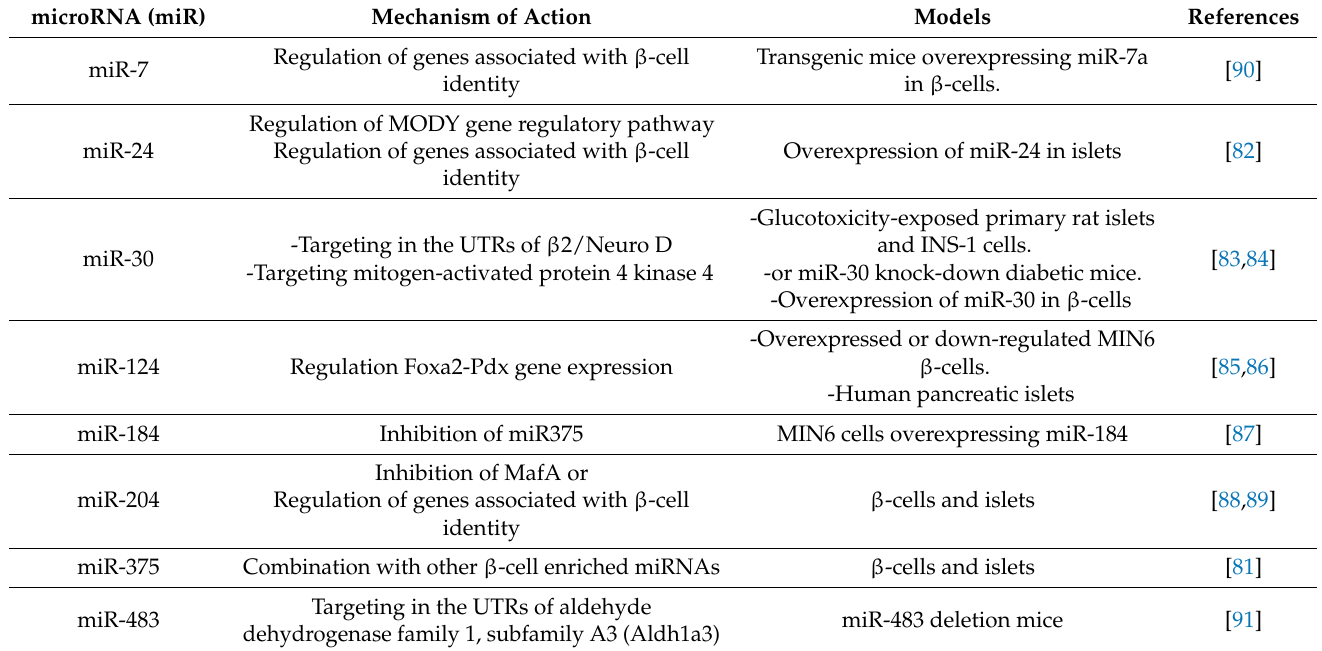
Table 1. MicroRNAs potentially associated with pancreatic β -cell dedifferentiation in type 2 diabetes mellitus. microRNA